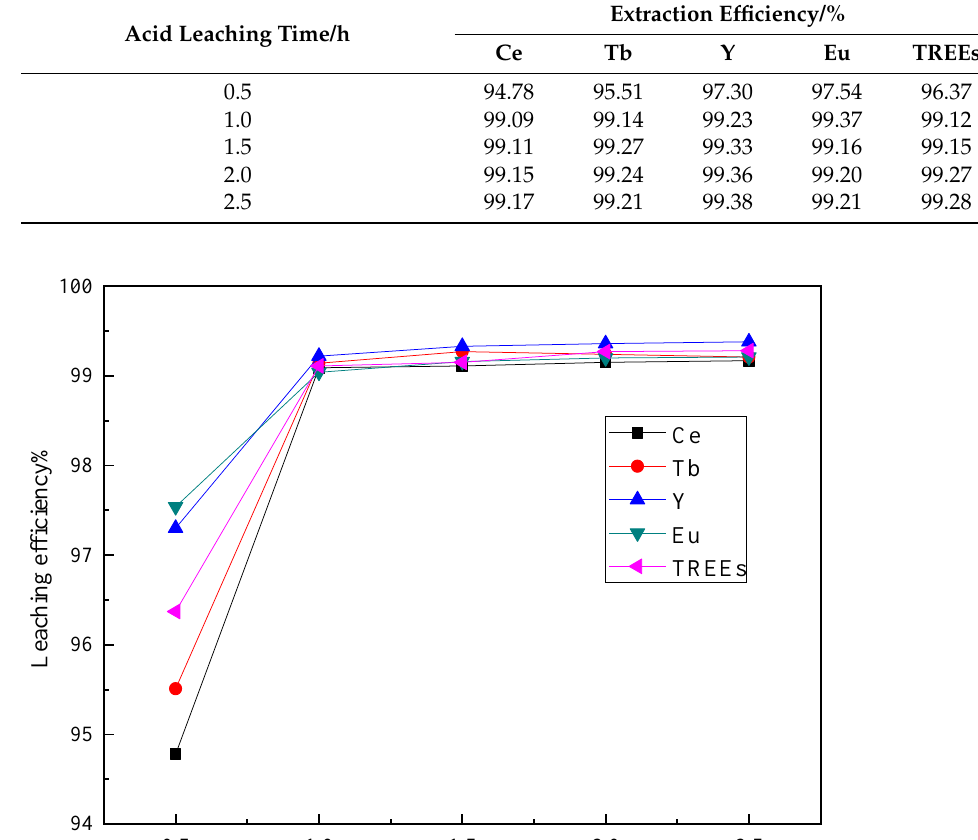
Table 8. Extraction efficiency of Ce, Tb, Y, Eu, and total rare earth under different acid leaching times (oxygen concentration in the mixed gas of 0.4%, roasting temperature of 700 °C, roasting time of 2.5 h, material ratio of phosphor powder to alkali 1:3, HCl solution concentration of 4 mol·L −1 , acid leaching temperature of 60 °C, and liquid–solid ratio of 10:1). Extraction Efficiency/% Acid Leaching Time/h